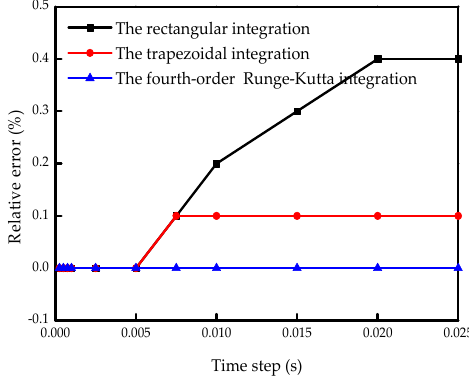
Figure 4. Relative stiffness errors by three integration methods.